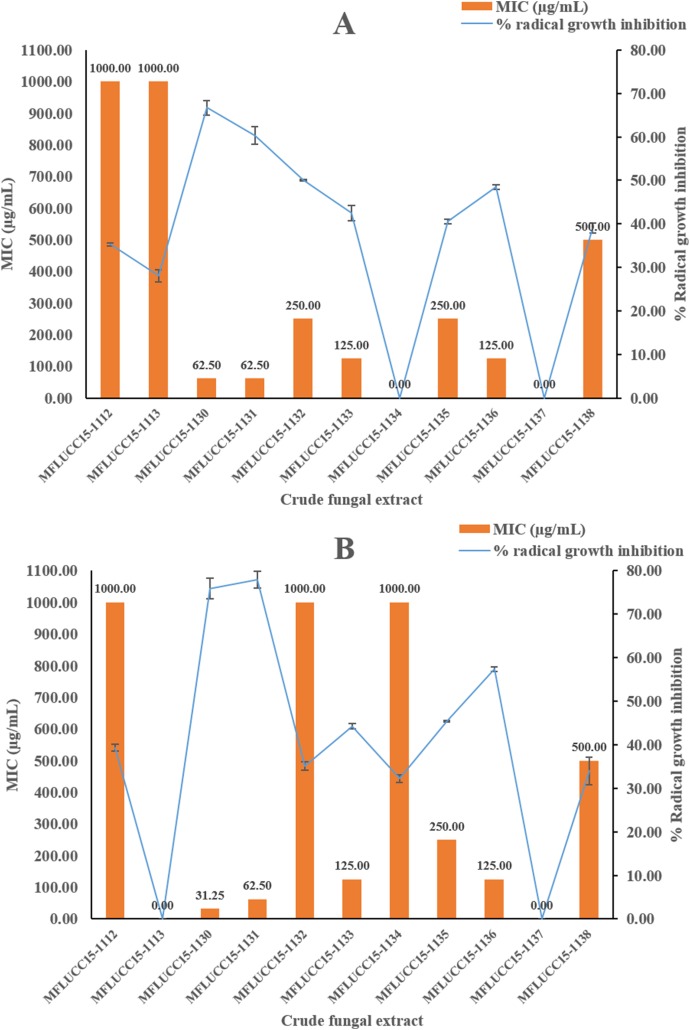
Antifungal activities of crude fungal extracts against C. albicans (A) and A. niger (B), expressed as percentage of radical growth inhibition and MIC.Each bar graph indicates the percentage of radical growth inhibition of crude fungal extracts at a concentration of 1,000 μg/mL (triplicate analysis). No standard deviation value was obtained from this experiment. Each line indicates the MIC (μg/mL) of crude fungal extracts against each fungal pathogen tested. Each error bar was calculated from a standard deviation value derived from a triplicate experiment.